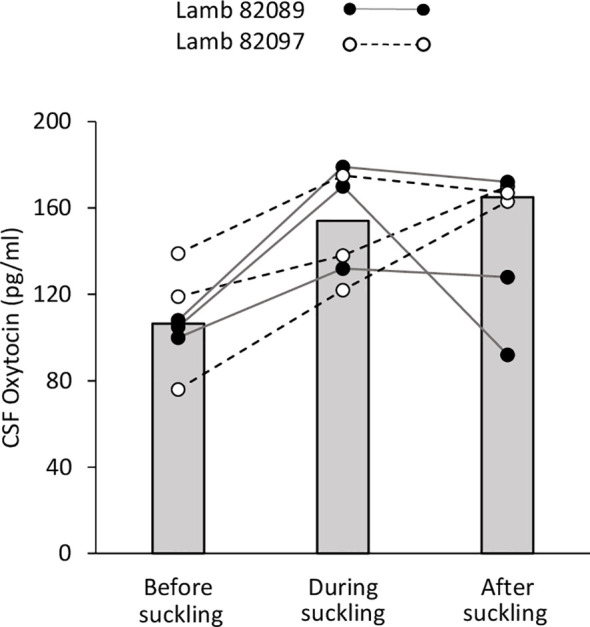
Effect of suckling on oxytocin levels in the CSF. Samples were taken during a 5-min period each time, before, during and after suckling from two lambs (82089 and 82097). Data are expressed as medians (gray bars) and individual data points.